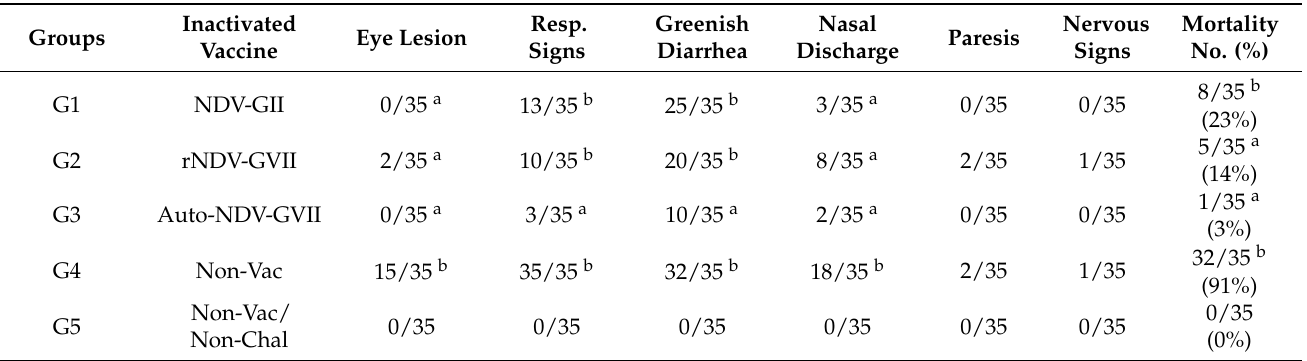
Table 2. Clinical signs and mortality in vaccinated and non-vaccinated challenged groups on day 28 with VNDV genotype VII.I.I.